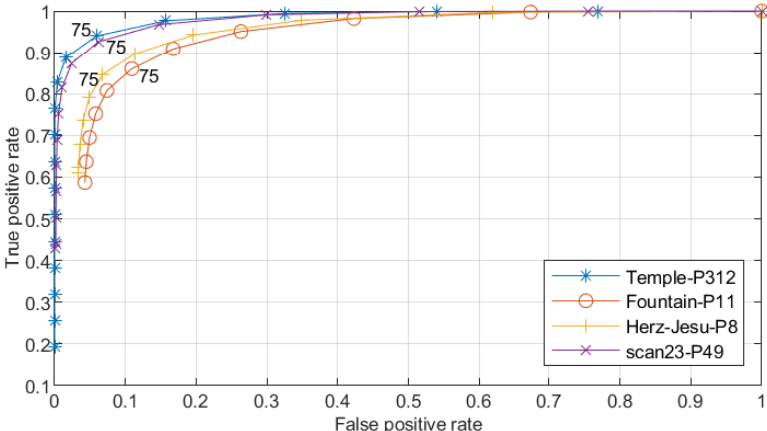
Figure 7. Free-space support threshold evaluation. The true positive rates and false positive rates in the same four datasets as in Figure 6 are evaluated by setting different free-space support